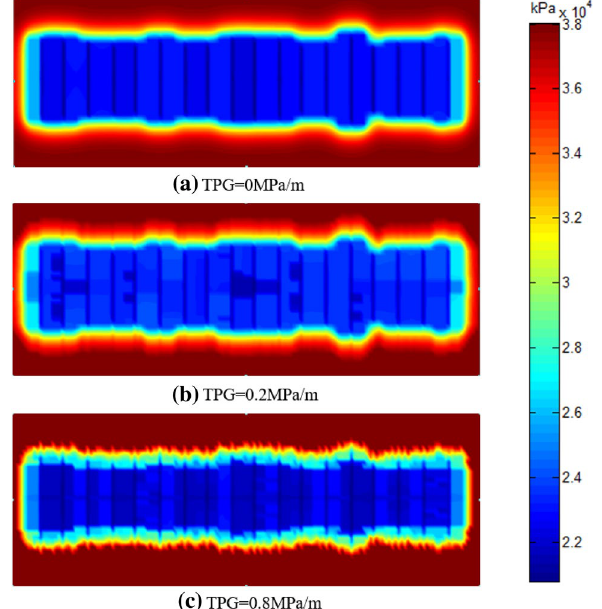
Fig. 4 Pressure maps at 4000 days